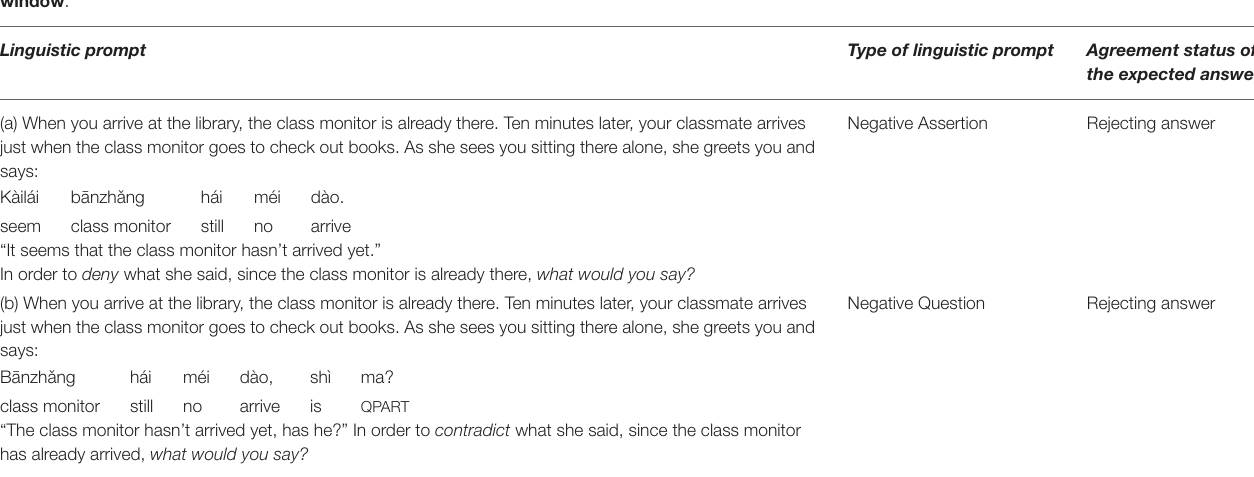
TABLE 1 | Sample of two of the discourse contexts that served as a prompt for the REJECT condition (i.e., Negative Assertion and Negative Question). Situation : Every night your classmate, your class monitor and you go to the library to study. You always sit down together at the table in front of the window .